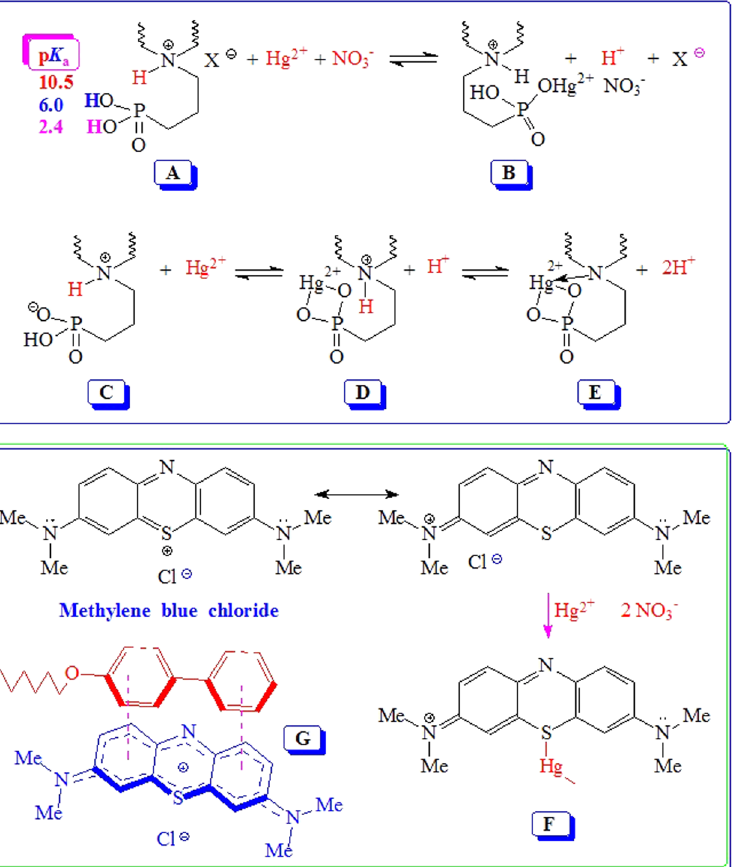
Figure 11. Aminopropylphosphonate as a chelating ligand and Hydrophobic interaction between the MB and the p-phenylphenoxy